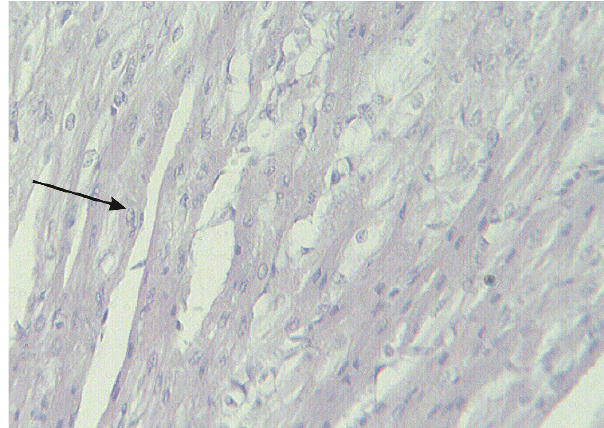
Figure 1 - Interstitial edema and wavy fibers.